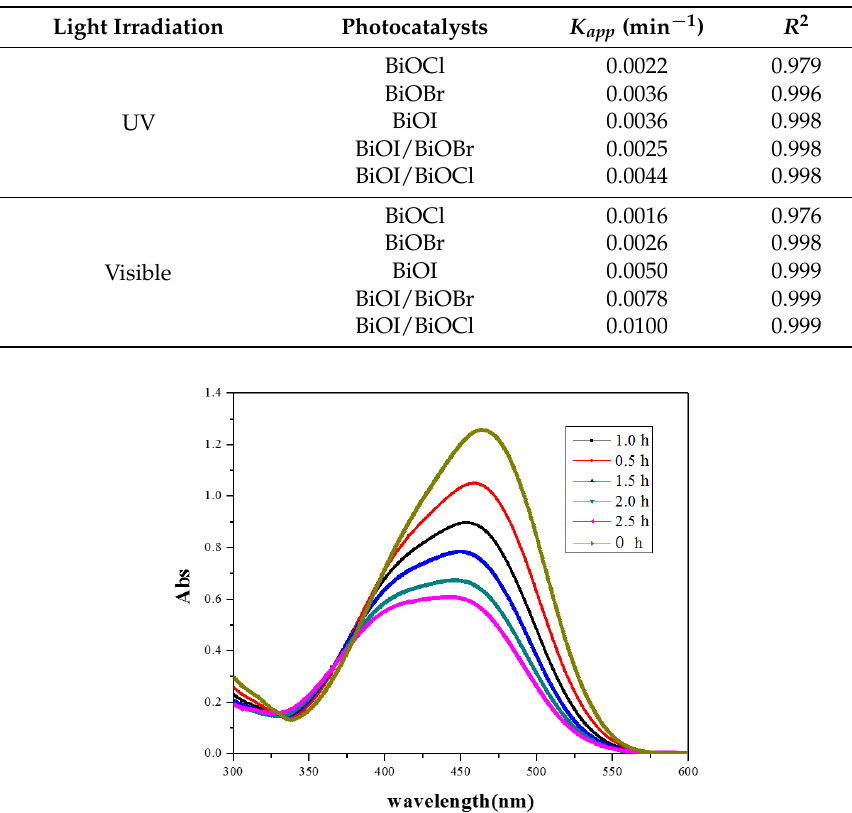
Table 3. Photodegradation rate constants of various catalysts under UV and visible light.